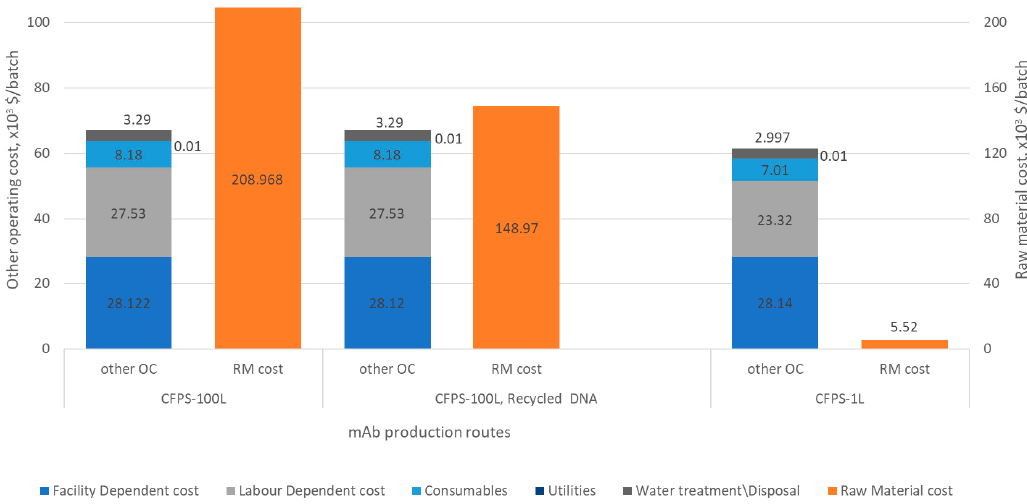
Processes 2020 , 8 , x FOR PEER REVIEW Supplementary Figure S4.